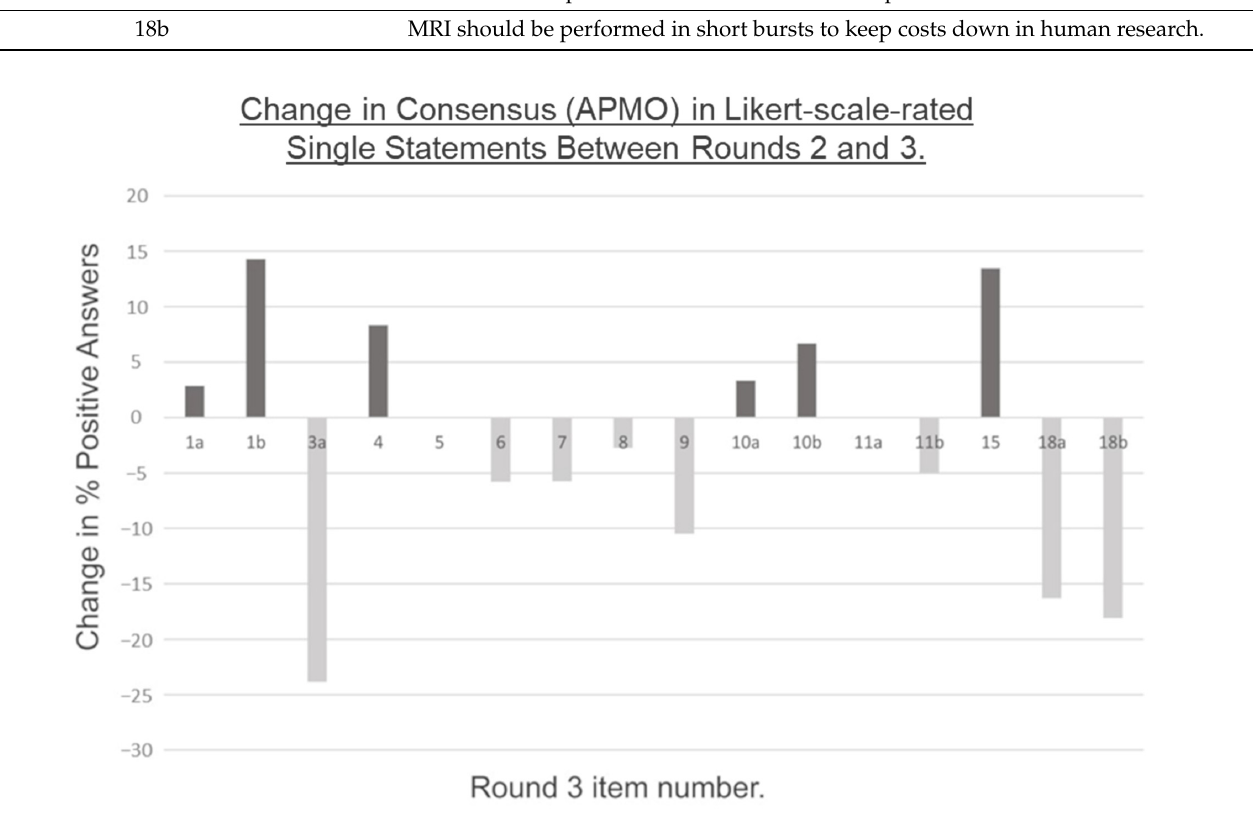
Figure 6. Change in APMO between rounds 2 and 3 for Likert-scale-rated single statements that did not reach consensus in this Delphi study.